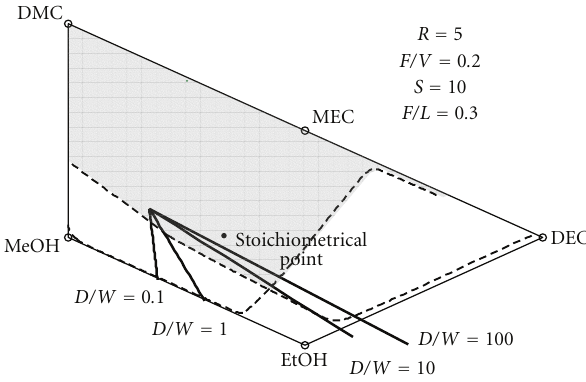
Figure 8: Feasible region of middle-vessel column with two extract- ive